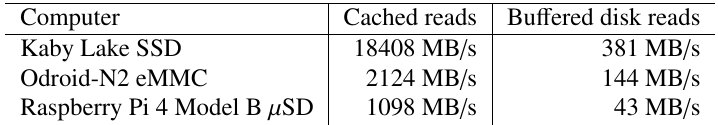
Table 3. Average of three hdparm runs.